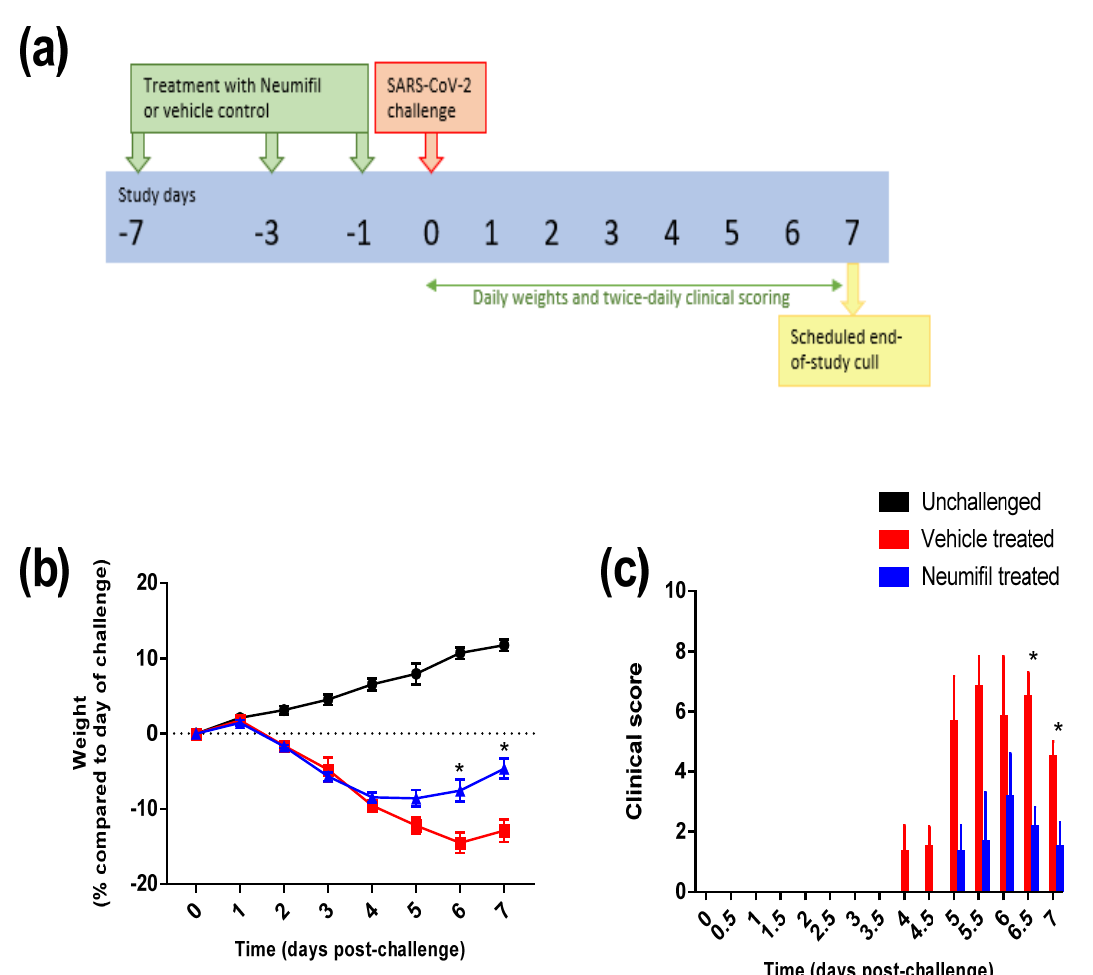
Figure 2. Clinical disease progression of Neumifil-treated compared with mock-treated hamsters after challenge with SARS-CoV-2: ( a ) schematic overview of the study, with hamsters receiving Neumifil three times prior to challenge; ( b ) changes in weight compared with the day of challenge; ( c ) clinical scores. Data show mean values with error bars denoting standard error of the mean. *, p < 0.05 for comparison between vehicle-treated and Neumifil-treated groups (Mann–Whitney test). n = 6 hamsters per group.